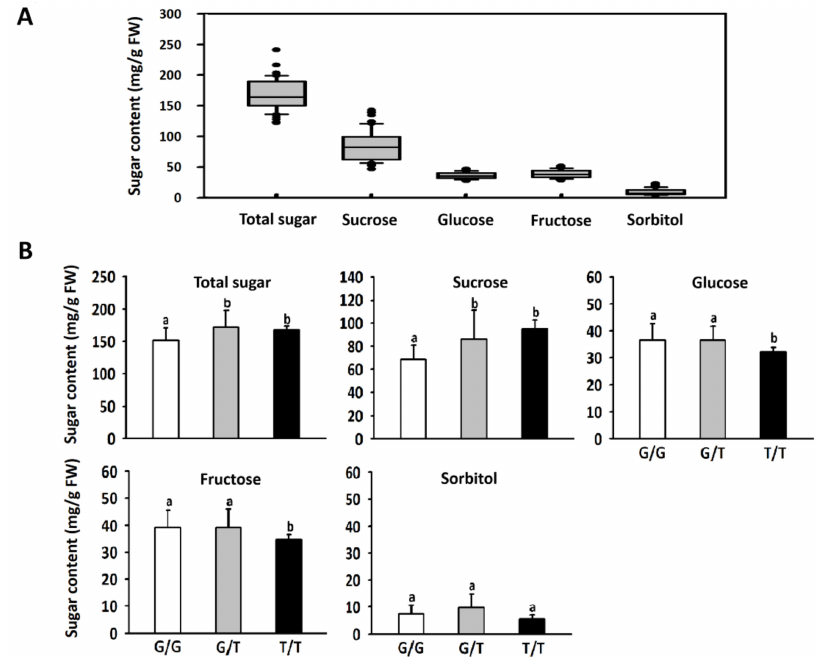
Figure 3. Distribution of soluble sugar content in mature fruits of 61 peach cultivars ( A ), and mean values of sugar contents in mature peach fruits of di ff erent genotypes at the G / T locus ( B ). Di ff erent lowercase letters indicate significant di ff erences between genotypes (Student’s t test at p <